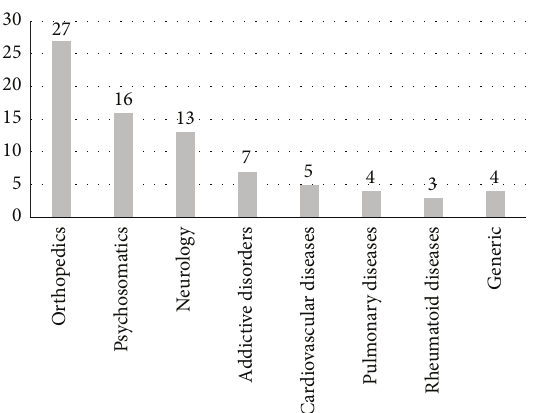
Figure 1: Indications represented in the database of good practice examples. Note: given is the number of examples per indication. The number of examples does not equal 𝑛 = 63 as some examples relate to more than one